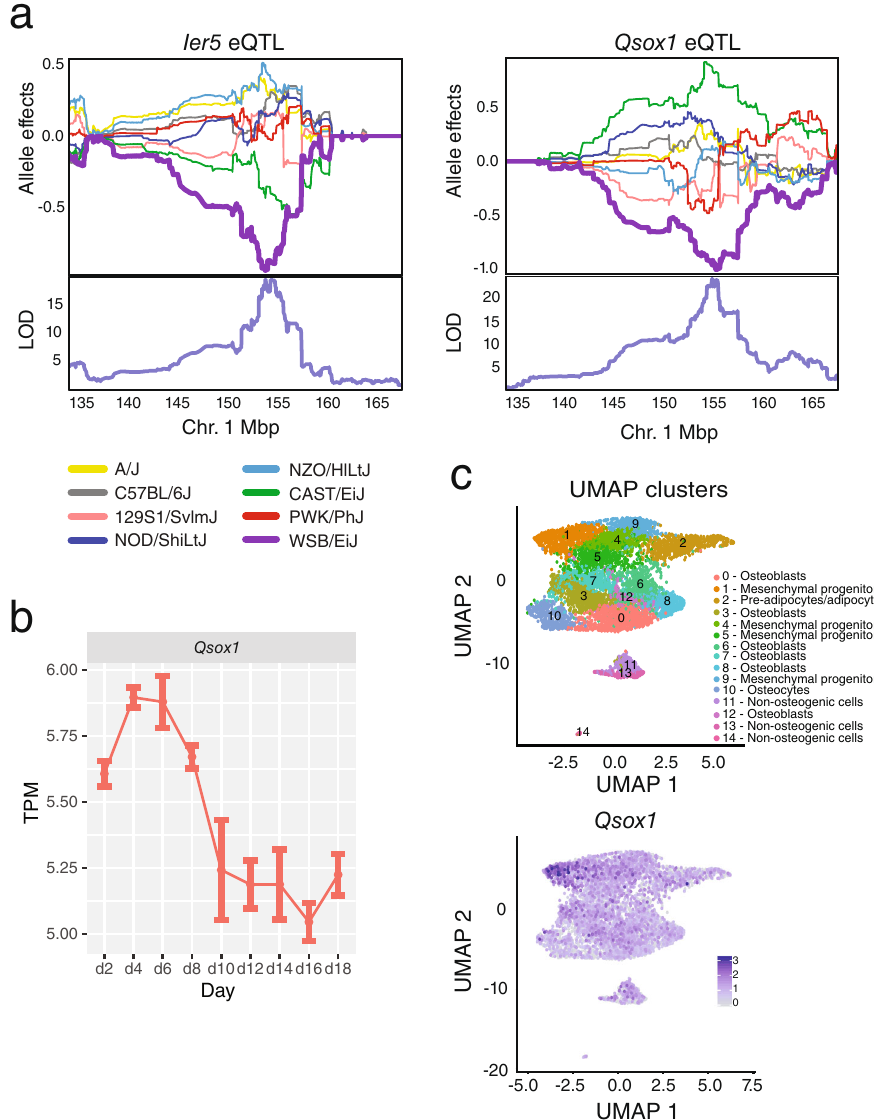
Fig. 7 Characterization of Qsox1 . a The top panel shows allele effects for the DO founders for Ier5 and Qsox1 expression an interval on chromosome 1 (Mbp, colors correspond to the founder allele in the legend). Y -axis units are best linear unbiased predictors (BLUPs). Bottom panels show each respective QTL scan. LOD (logarithm of the odds) score threshold for autosomal eQTL is 10.89 (alpha = 0.05). b Qsox1 expression in calvarial osteoblasts. For each time point, N = 3 independent biological replicates were examined. Error bars represent the standard error of the mean. TPM transcripts per million. c Single-cell RNA-seq expression data. Each point represents a cell ( N = 7092 cells). The top panel shows UMAP clusters and their corresponding cell-type. The bottom panel shows the expression of Qsox1 . The color scale indicates normalized gene expression